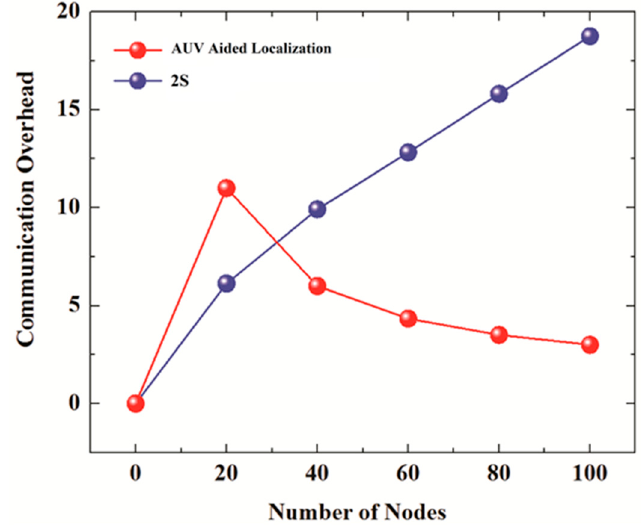
Figure 1. Communication overhead of 2S and AUV Aided Localization clustering.